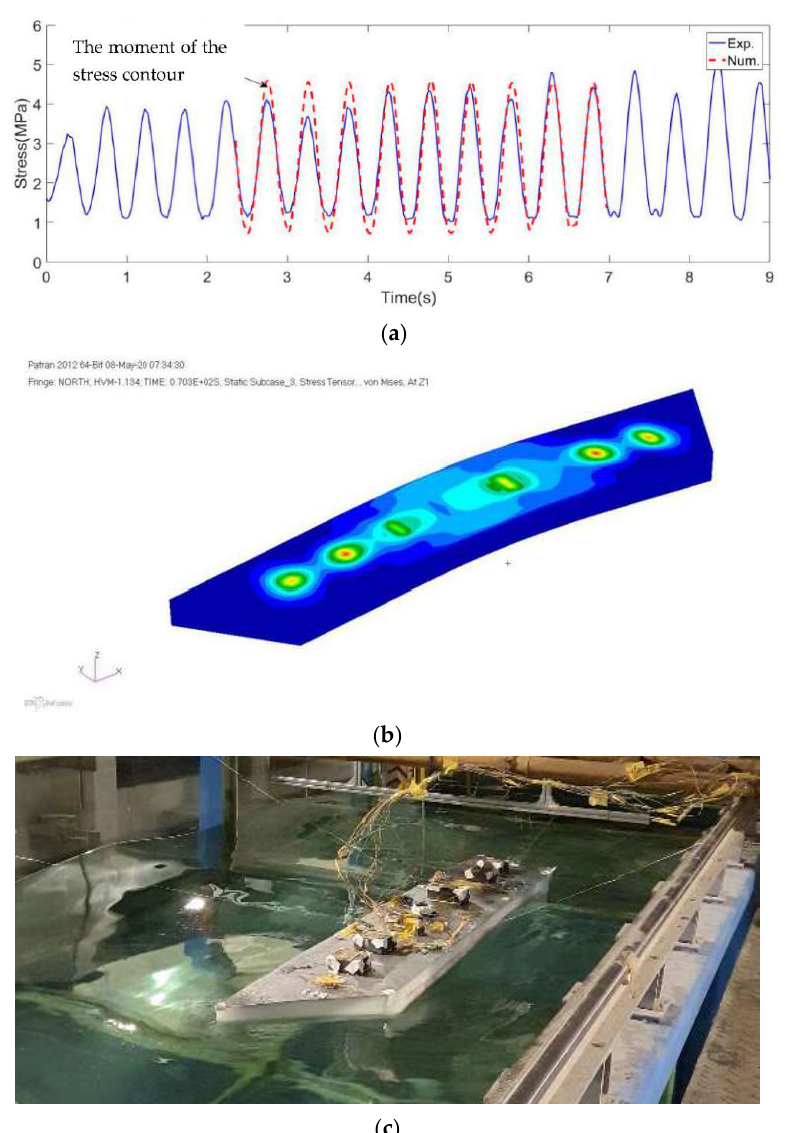
Figure 8. Result of Case 1. ( a ) The time domain history of stress in the measuring point No. 1 of case 1. ( b ) Stress contour at hogging of the case 1. ( c ) The experimental scene at hogging of the case 1.